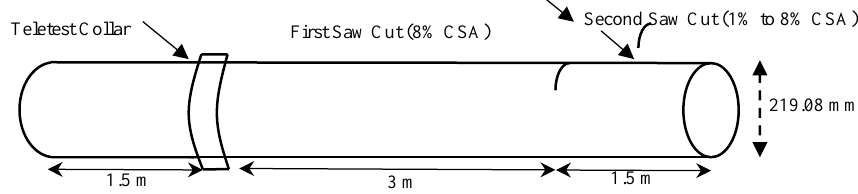
Figure 10. Experimental setup for the same eight inch pipe (Figure 7) with two saw cut defects.